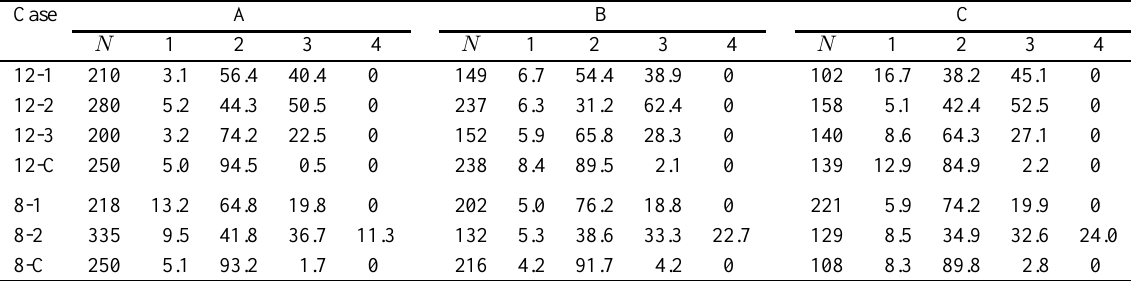
Spot counting in cell nuclei from the same specimen after three techniques: (A) visual counting after standard FISH; (B) semi- automated counting after standard FISH; (C) semi-automated counting after Fast -FISH. For all cases, the absolute number of cell nuclei N and the percentage frequencies of cell nuclei with 1, 2, 3, 4 hybridization spots are given. Cells without any hybridization signals were not considered. For the control cases 12-C and 8-C, always two spot cell nuclei were expected. Thus the measured percentages of one and three spot cell nuclei can be used as a measure for the methodological error rates due to insufficient hybridization, optical fusion and reduced stringency. (See also Fig.